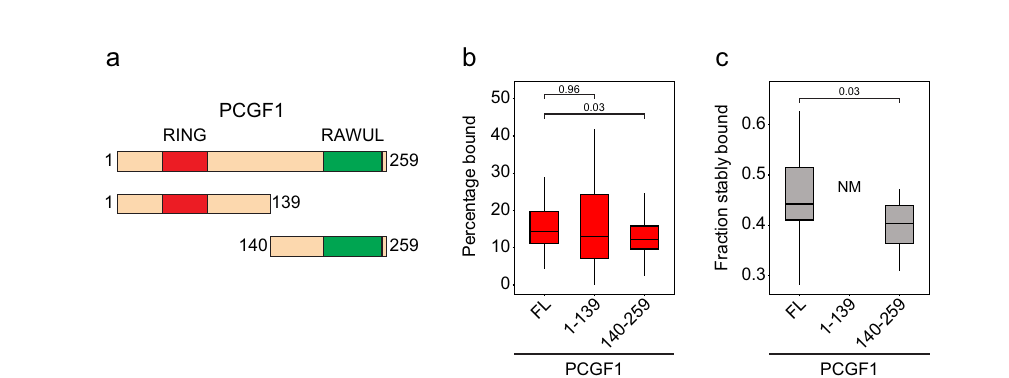
Fig. 8 PRC2 and H3K27me3 contribute to the binding frequency of canonical PRC1 but not its stability. a A schematic illustrating the dTAG-SUZ12 system. SUZ12 is tagged endogenously and is depleted by addition of dTAG-13. b Western blots for RING1B-HT, PCGF2-HT and HT-PCGF6 cell lines with the dTAG-SUZ12 system showing rapid (<1 hr) depletion of SUZ12 and loss of H3K27me3 after 96 hrs of dTAG-13 treatment. TBP and H3 are included as loading controls. Symbol (*) indicates a nonspeci fi c band present in the parental cell line which remains after SUZ12 depletion. n = 1 biological replicate. Source data are provided as a Source Data fi le. c A box plot indicating the percentage of RING1B, PCGF2, and PCGF6 molecules in the bound state with and without 96 hr dTAG-13 treatment, as determined from SPT. Box plots represent measurements from n = 90 movies from 2 experiments each. Indicated p - values were calculated using a two-tailed Student ’ s t test. Source data are provided as a Source Data fi le. d A box plot indicating the fraction of RING1B, PCGF2, and PCGF6 molecules exhibiting stable binding with and without 96 hr dTAG-13 treatment. Box plots represent measurements from n = 16 movies from 2 experiments each. Indicated p -values were calculated using a two-tailed Student ’ s t test. Source data are provided as a Source Data fi le. e A box plot indicating the stable binding times for RING1B, PCGF2, and PCGF6 with and without 96 hr dTAG-13 treatment. BP (beyond photobleaching) and an arrow indicates proteins for which stable binding exceeded the photobleaching time. Box plots represent measurements from n = 16 movies from 2 experiments each. Source data are provided as a Source Data fi le. f Maximum intensity projections of nuclear RING1B, PCGF2 and PCGF6 signal with and without 96 hr dTAG-13 treatment. Yellow arrowheads indicate single Polycomb bodies. Scale bar = 5 μ m. n > 50 cells per condition from 2 experiments. g Box plots showing the number of Polycomb bodies detectable for RING1B, PCGF2 and PCGF6 with (green) and without (blue) 96 hr dTAG-13 treatment. n > 50 cells per condition from 2 experiments. Indicated p -values were calculated using a two-tailed Student ’ s t test. Source data are provided as a Source Data fi le. h Box plots comparing the number of nuclear foci counted for PCGF2 with (green) and without (blue) 96 h dTAG-13 treatment. Foci were divided into quartiles based on focus volumes in untreated cells. n > 50 cells per condition from 2 experiments. Indicated p -values were calculated using a two-tailed Student ’ s t test. Source data are provided as a Source Data fi le. In c – e and g – h , boxes represent the interquartile range (IQR), the middle line corresponds to the median, and whiskers extend to the largest and smallest values no more than 1.5 x IQR from the box. Values outside of this range are not plotted, but are included in all analyses.